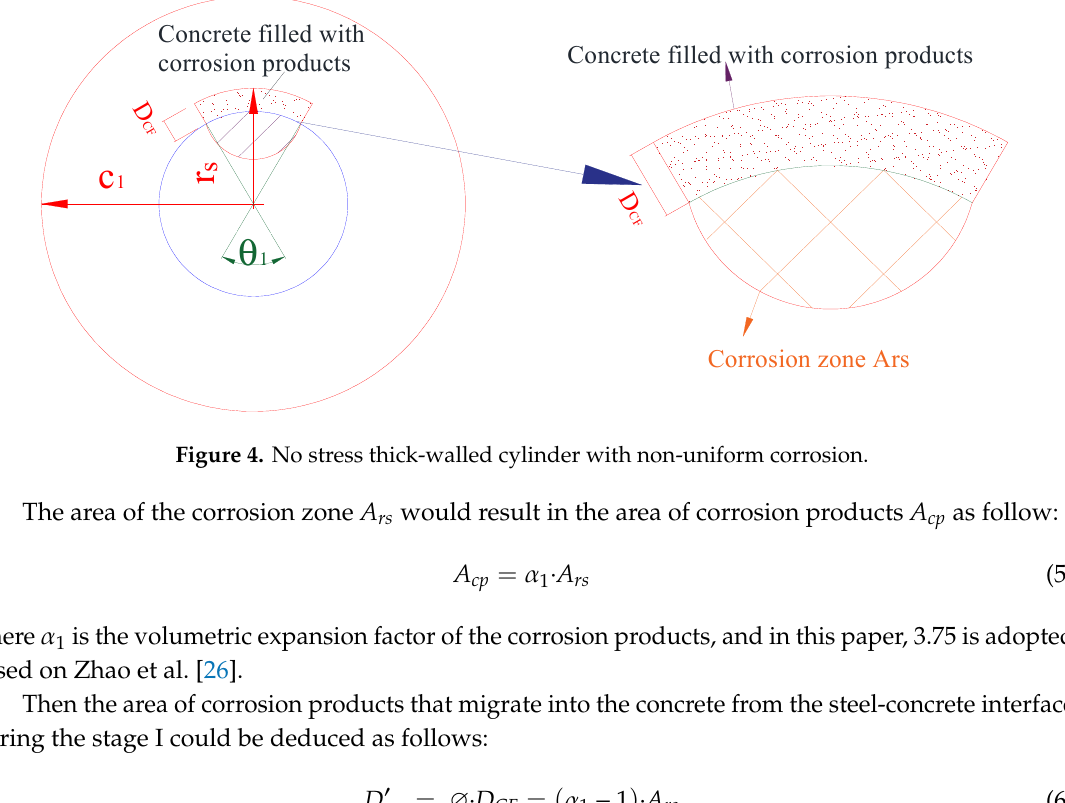
Figure 5. No cracked thick-walled cylinder with expansion stress.